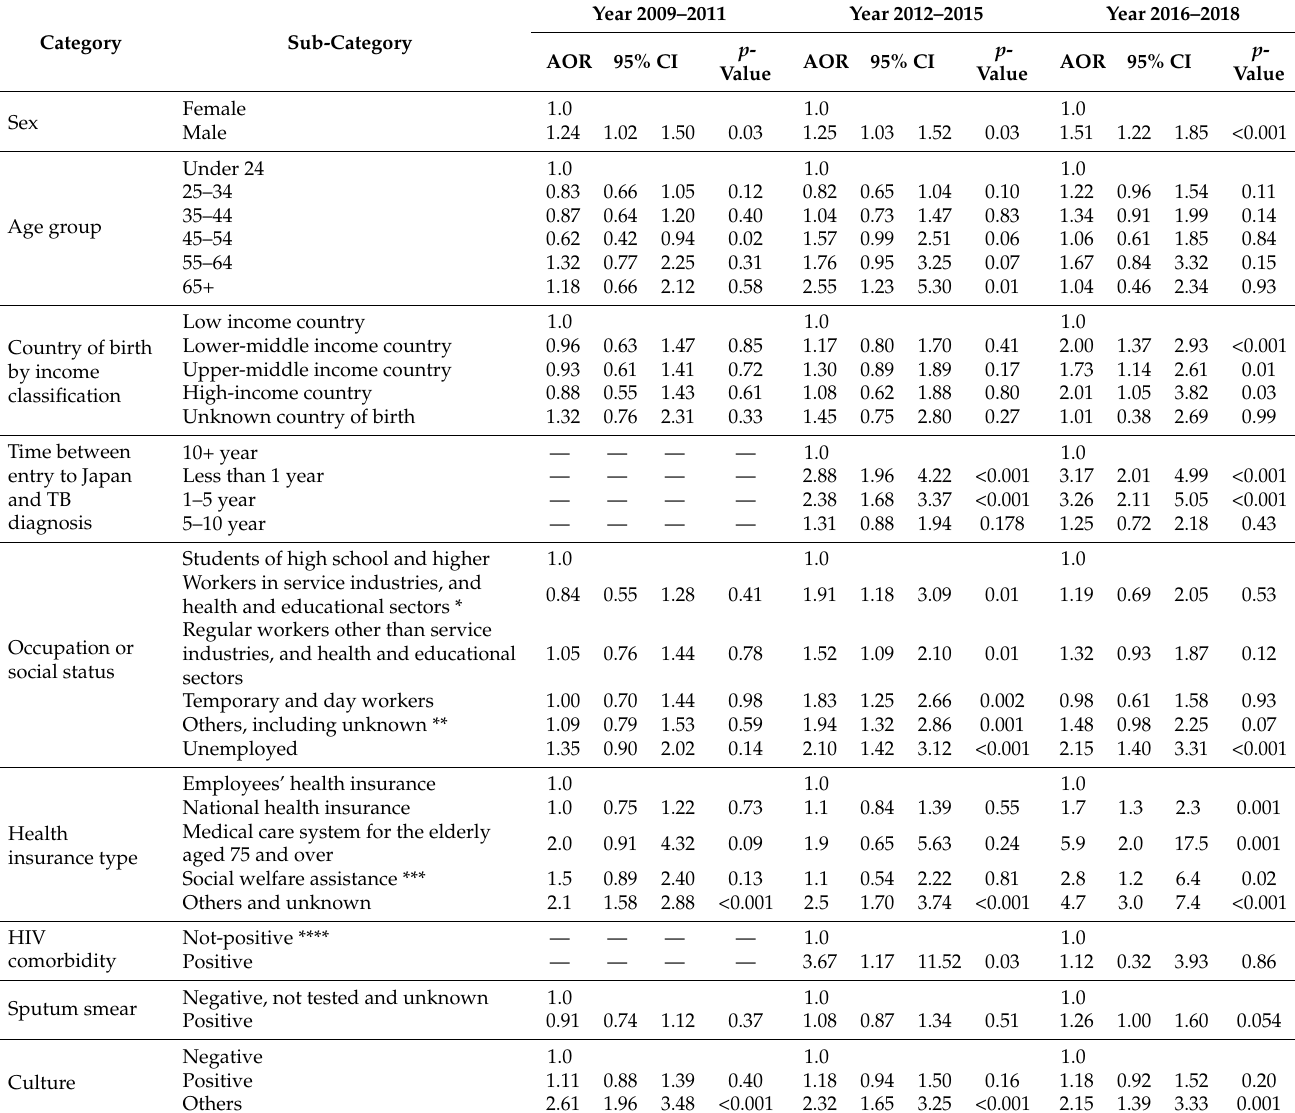
Table 4. Multiple logistic regression of risk factors associated with treatment non-success among overseas-born patients with pulmonary tuberculosis by year